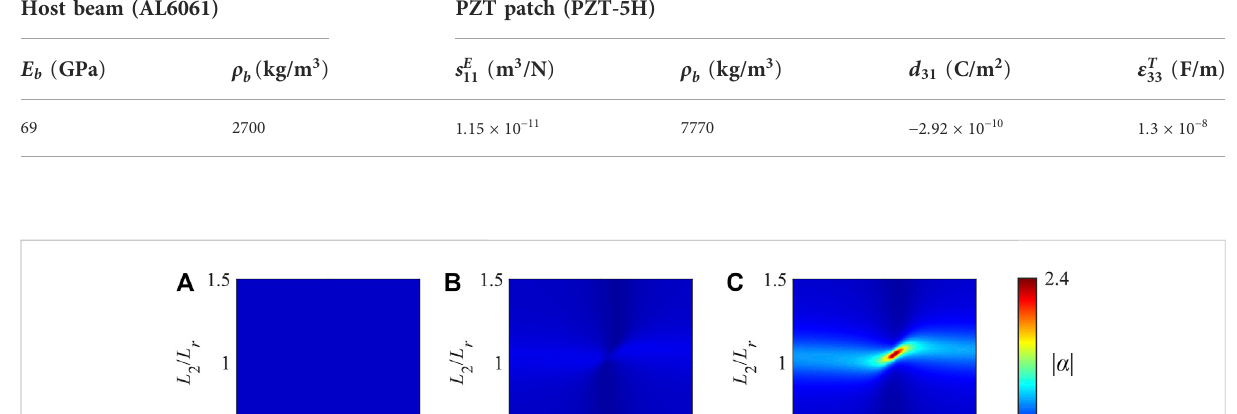
(cid:2) 100 Ω , R 1